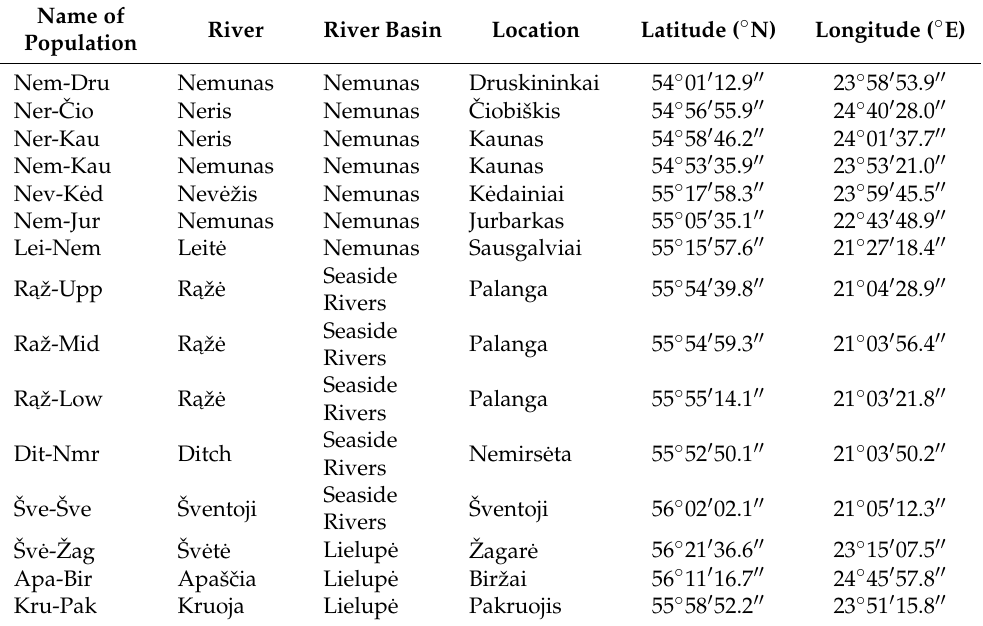
Table 1. The names and geographical locations of 15 populations of Lythrum salicaria in Lithuania (Figure 1) selected for element (macro-, microelement and non-essential) and AFLP [22]